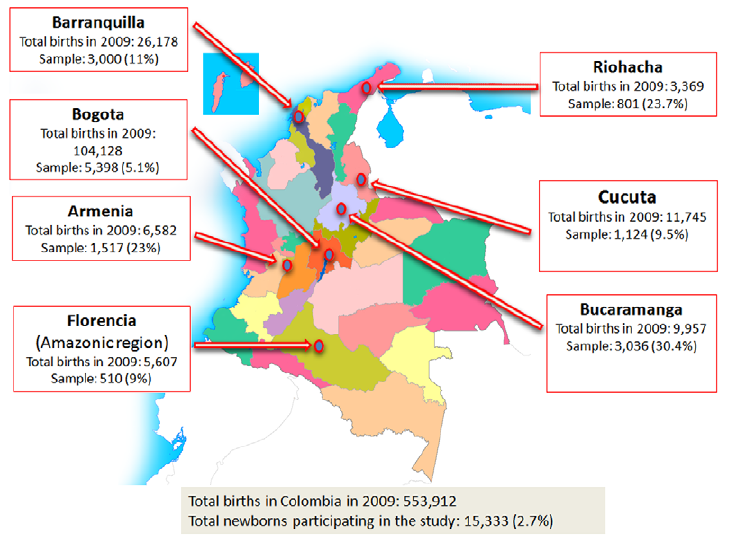
Figure 1. Geographical distribution and sample percent of the births. Colombian multicentric newborn screening for congenital toxoplasmosis.